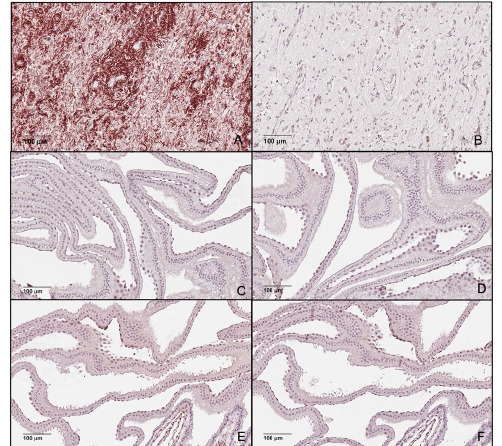
Figure 8. Photomicrograph of equine neurohypophysis ( A ) with positive staining for oxytocin with its corresponding negative epitope control ( B ) and the equine embryonic membranes at Day 16 and Day 18 post-ovulation demonstrating a lack of immunostaining for oxytocin 20 × ( C , E ), and the corresponding negative epitope control ( D , F